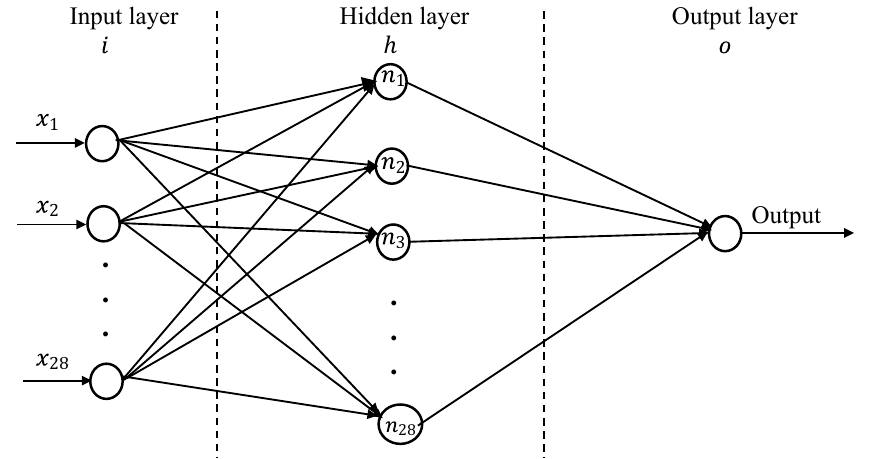
Figure 14. ANN architecture. A 3-layered network, with one output layer and one hidden layer. The input layer consumes the knowledge-enriched genome datasets comprising of extracted patterns of SOM learning of the respective genome isolates and additional knowledge sieved from analysis of the genome sequences (i.e., number of natural clusters discovered from the genomic tree, discovered SOM sub-strain clusters, and link sequences derived from cognitive maps of the various